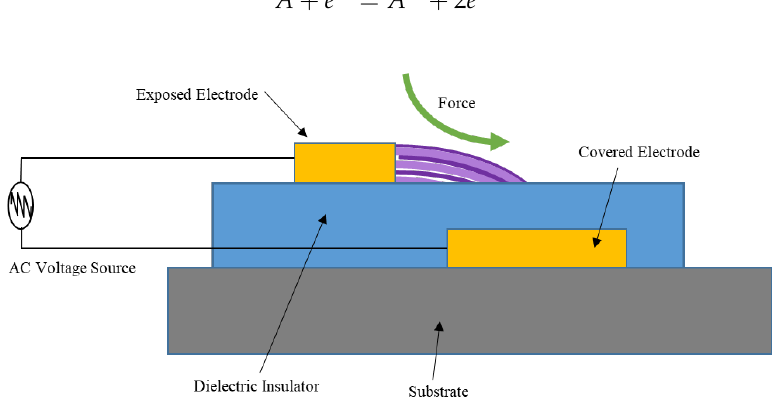
Figure 1. Schematic of a DBD plasma